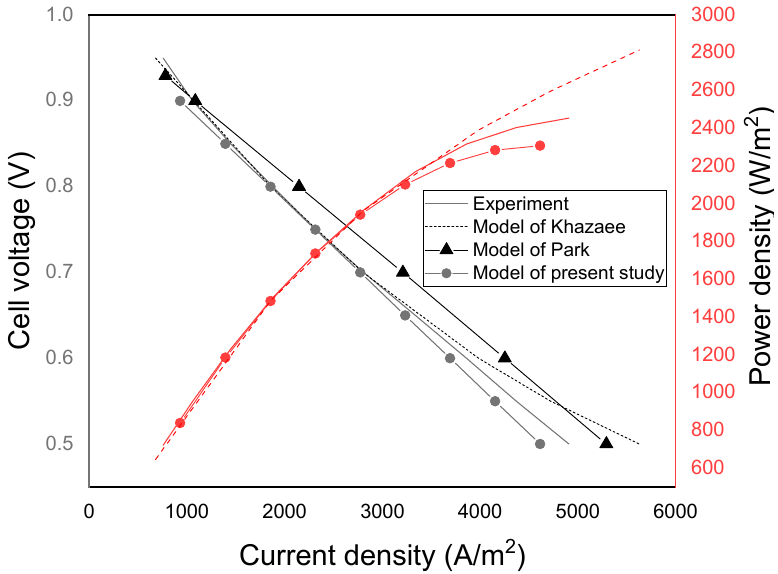
Figure 2. Comparison of the experimental and numerical results.